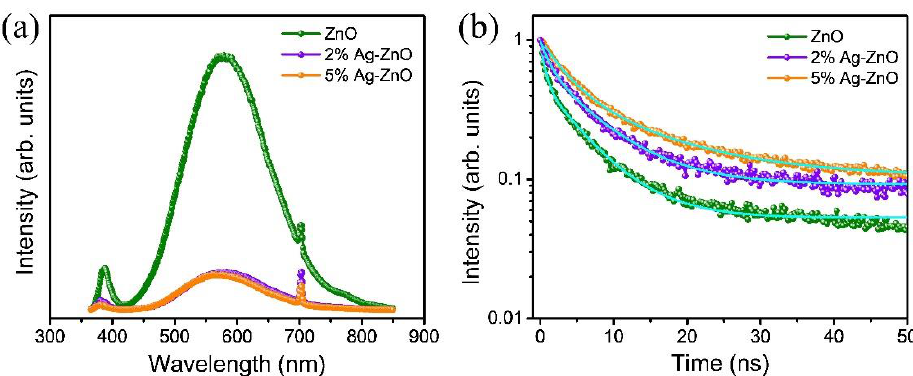
Figure 5. ( a ) Photoluminescence spectra, and ( b ) time-resolved photoluminescence spectra of the pure ZnO, 2% Ag-ZnO, and 5% Ag-ZnO.